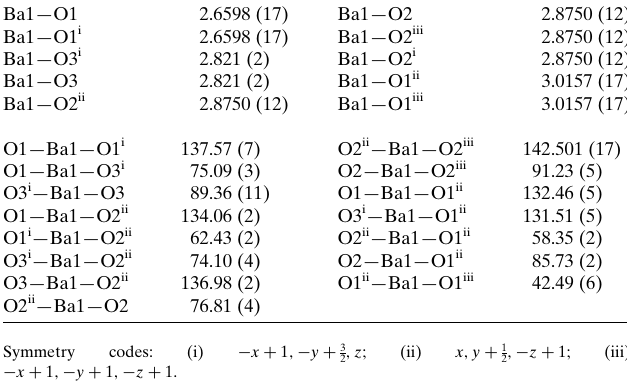
Table 2 Selected geometric parameters (A˚ , (cid:5) ) for (II).